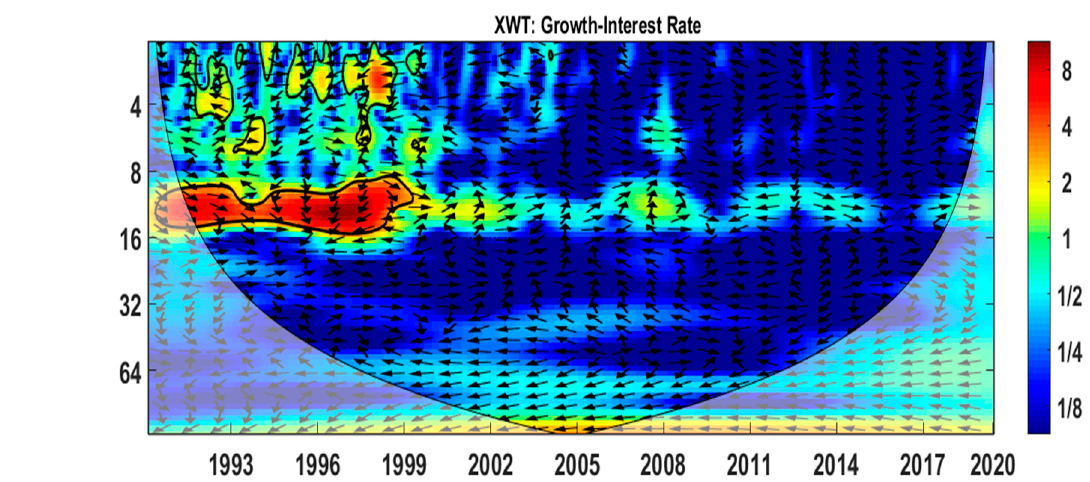
Figure 3. Cross-wavelet power spectrum. Panel ( a ): Growth-Inflation, ( b ) Growth-Interest rate. Source: Author’s own contribution.